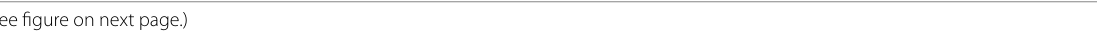
figure on next Fig. 3 The railway modernization program. During a very dry summer, a collective of inhabitants mobilized against the hydrological impact of the project and claimed that the water traffic forecasts were not credible in a context of economic crisis. Following a ministerial reshuffle, the new government abandons the canal project in favor of a railway modernization project and ecological restoration of the Sensée and the Somme. The existing old canal is landscaped for river tourism. A network of paths and hedges offset the impacts of railway developments. The train offers fewer export outlets, but agriculture is turning to agro-ecology and local markets. New farming practices limit mudflows. It also improves water quality. Authorities occasionally authorize pumping in the existing canal is for irrigation and tourism